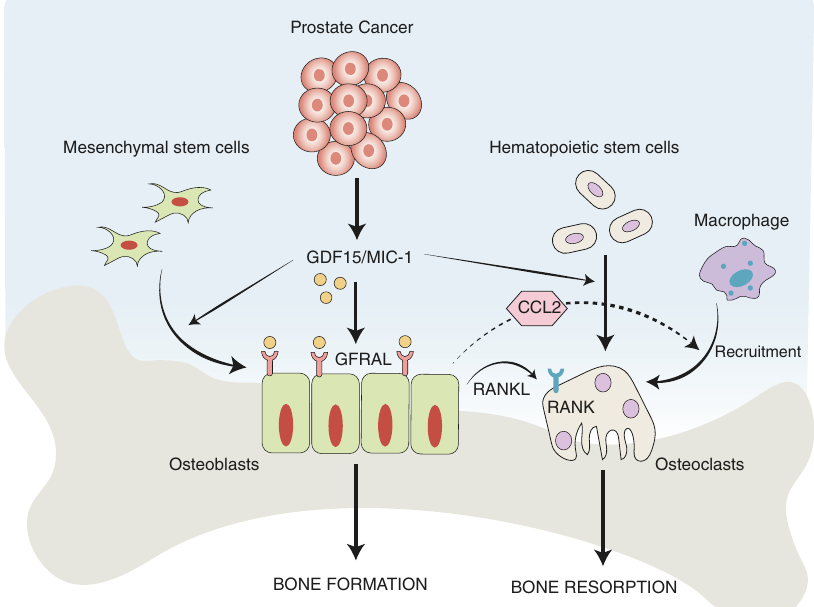
Fig. 7 Overall mode of action of PCa-secreted GDF15 on bone metastasis. GDF15 secreted from PCa modulates the activity of bone marrow stromal cells through GFRAL/RET signaling. The GDF15-mediated increase in osteoblastic CCL2 production recruits osteomacs (bone macrophages) toward bone and causes osteolysis of bone to create a metastatic niche for PCa cells in the bone microenvironment. In addition, GDF15 also primes osteoblasts to produce high levels of RANKL that favor the growth of PCa cells in